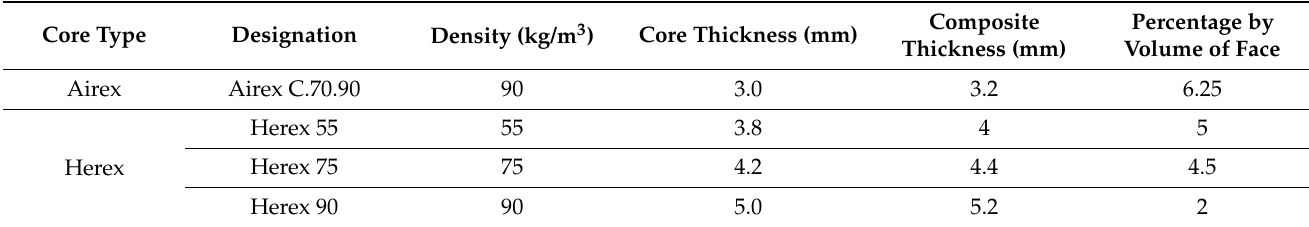
Table 2. Properties of sandwich composite cores.